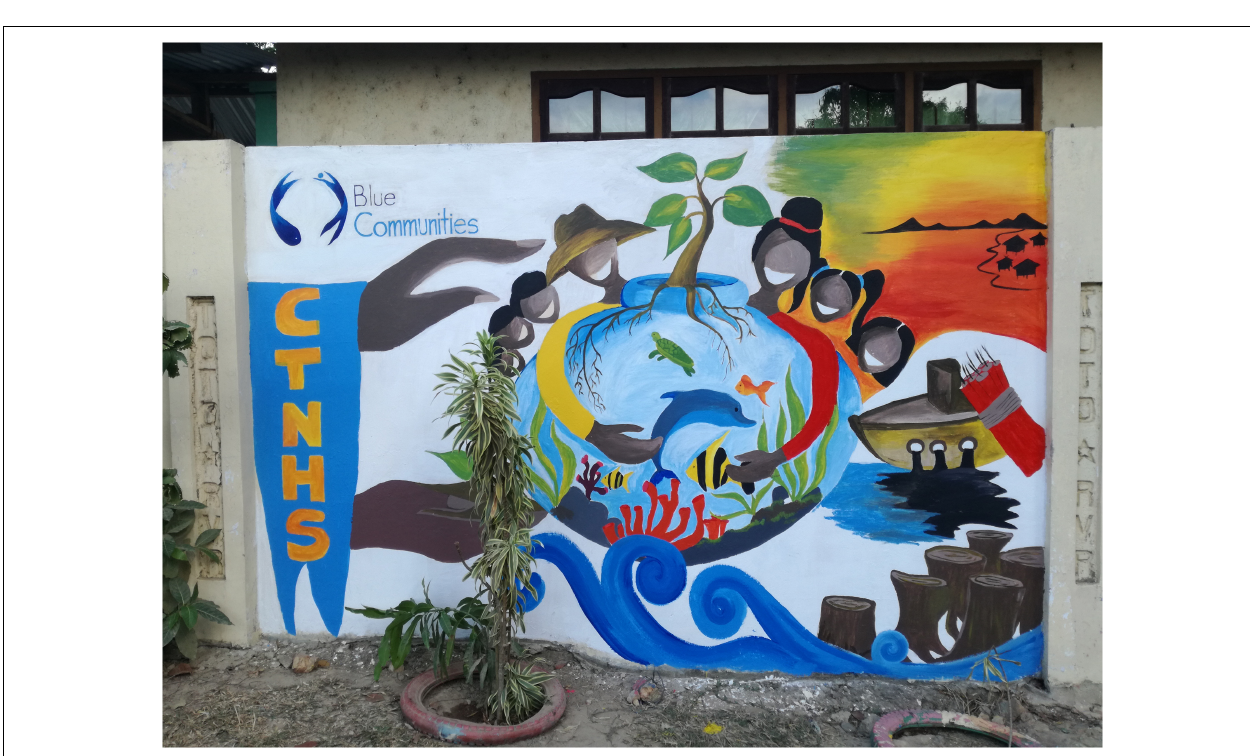
FIGURE 2 | Example of the Business as Usual Scenario drawing, converted into a mural painting in Taytay town after the study was conducted.